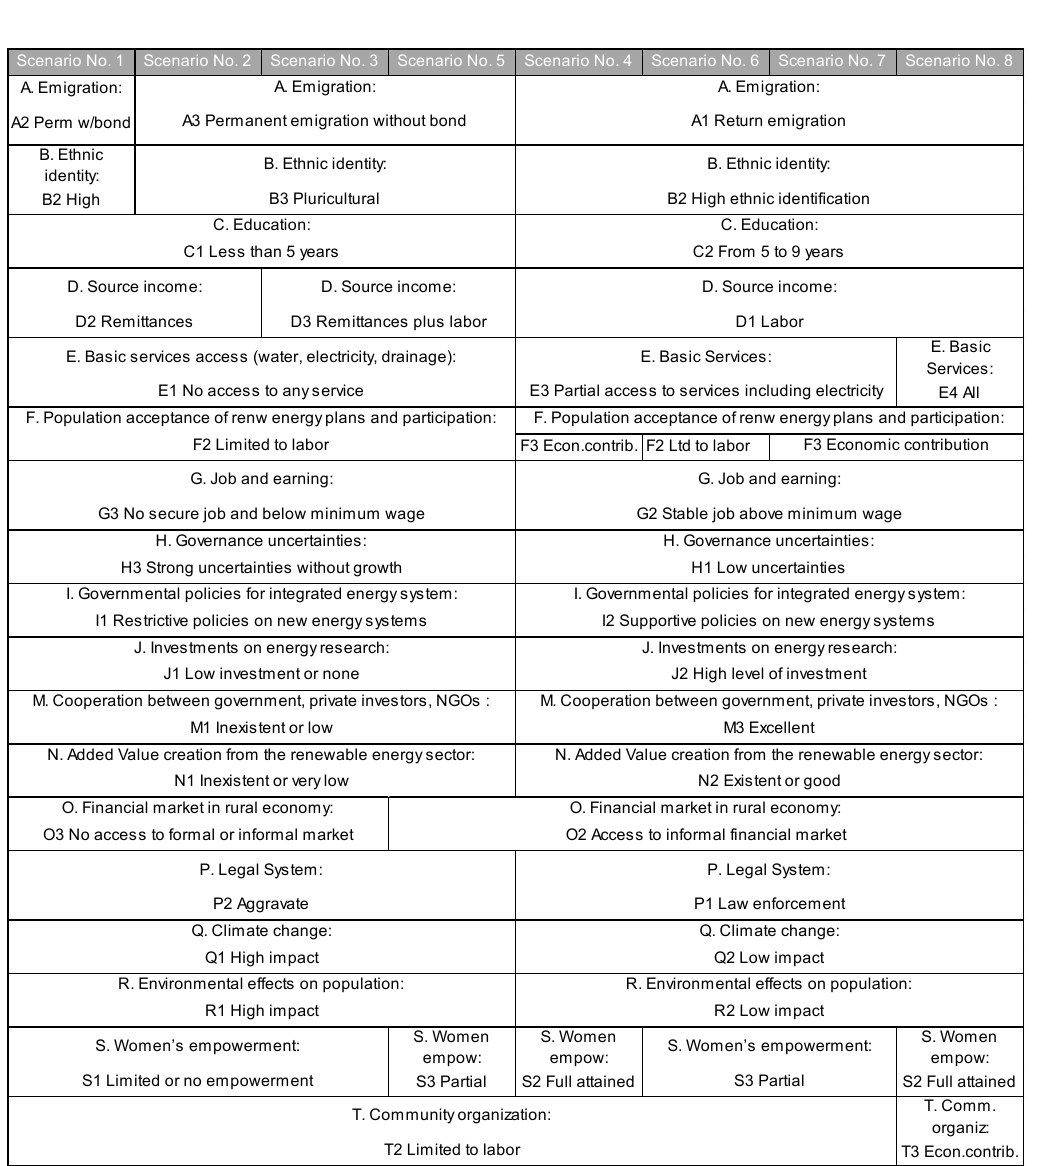
Figure 5. Consistent scenarios identified via CIB.